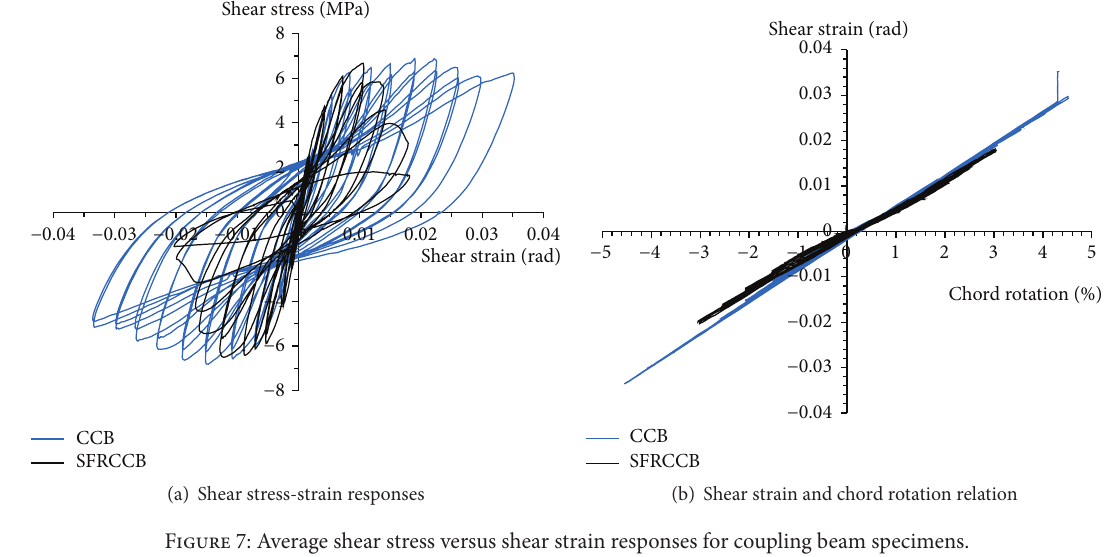
Figure 7: Average shear stress versus shear strain responses for coupling beam specimens.